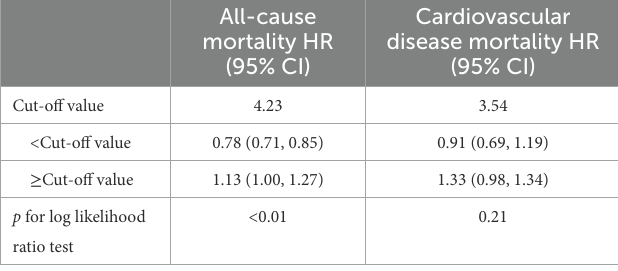
TABLE 3 The results of two-piecewise linear regression model between non-HDL-C and cause-specific mortality. All-cause mortality